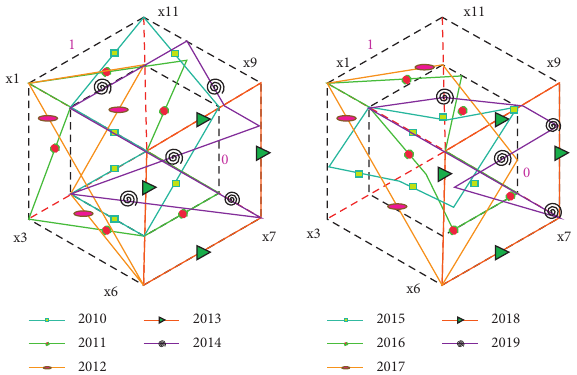
Figure 4: Comprehensive evaluation of energy consumption.